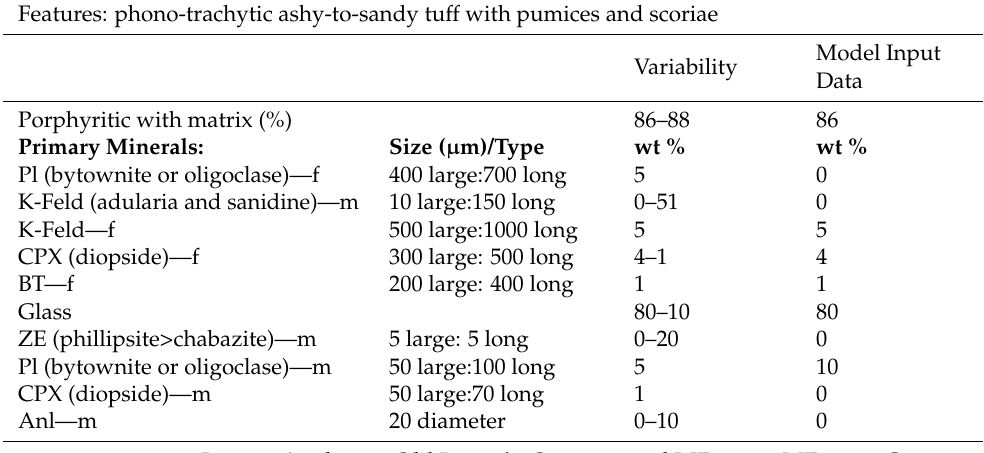
Table 1. Cont. 1000–1700 m, Tuff/Tuffites—Linked to the Campanian Ignimbrite Zeolitized Tuff Features: phono-trachytic ashy-to-sandy tuff with pumices and